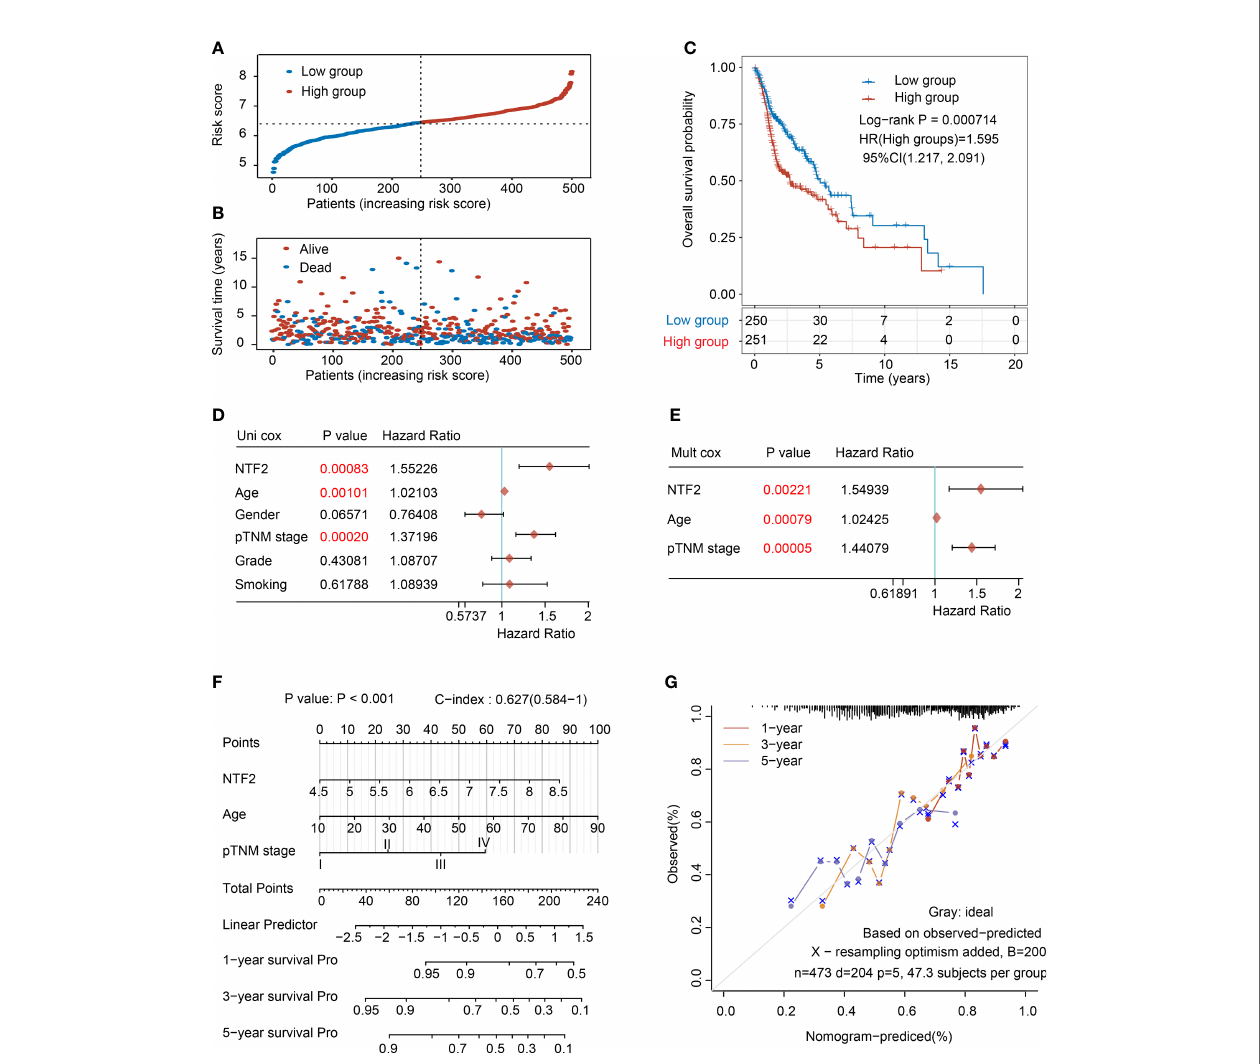
FIGURE 3 | Analysis of the prognostic risk signature based on NTF2 expression in TCGA database. (A) The risk score distribution of HNSCC patients. (B) Survival status and duration of patients. (C) Survival curve of NTF2 with high and low expression. The univariate (D) and multivariate (E) independent prognostic analysis of independent risk factors for overall survival (OS) in HNSCC patients. (F) Nomogram to predict the 1-, 3-, and 5-year overall survival of HNSCC patients. (G) Calibration curve for the OS nomogram model. The grey dotted line represents the ideal prediction